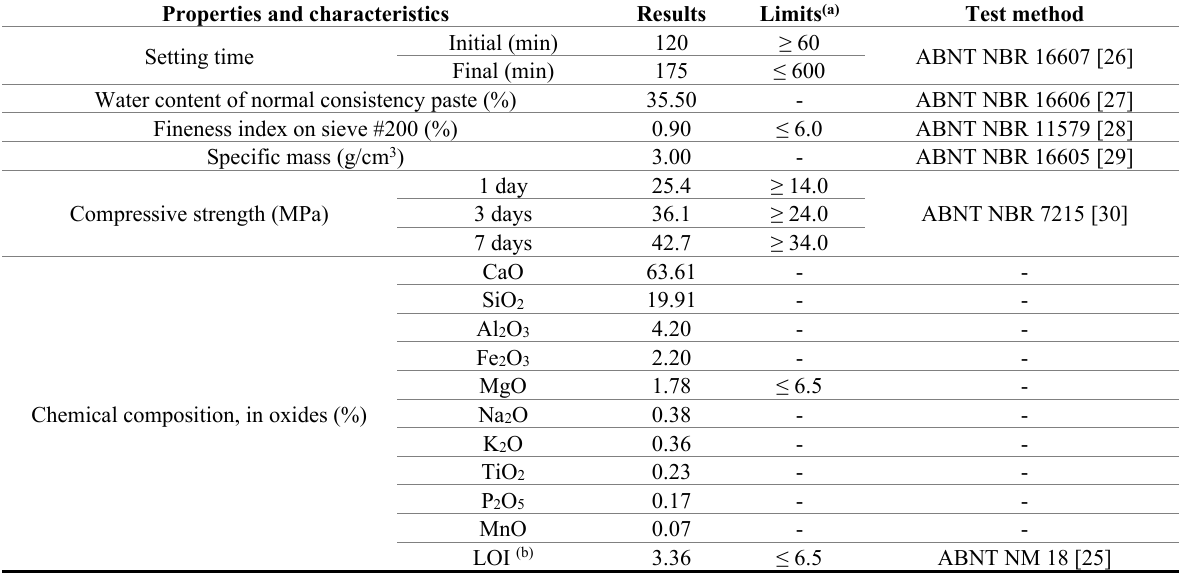
Table 1. Properties and characteristics of the Portland cement (CP V).